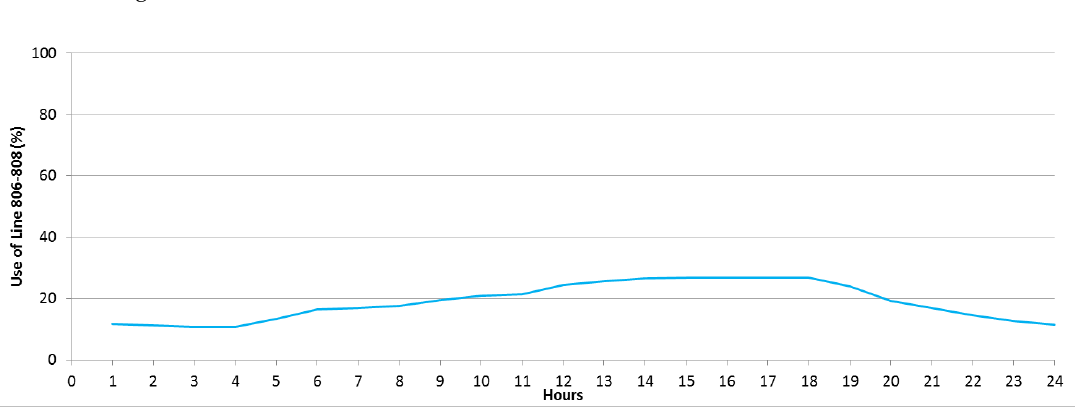
Table 4. Case 1 Maximum Additional kW on Bus 840 during Peak Hours.